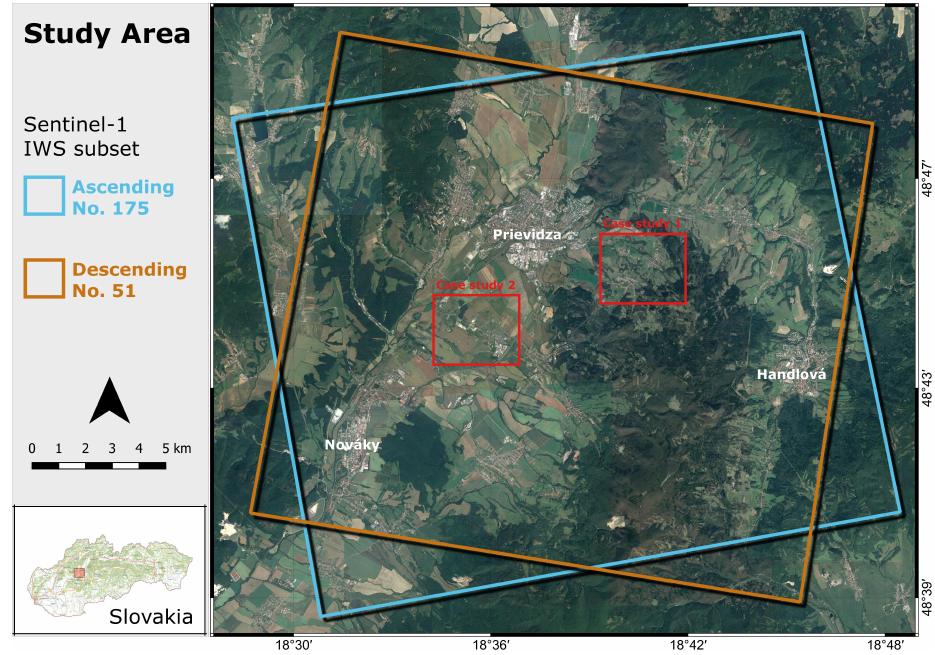
Figure 1. Area of interest (AOI) covering the Upper Nitra region, Slovakia. Basemap: Google, 2017 CNES.